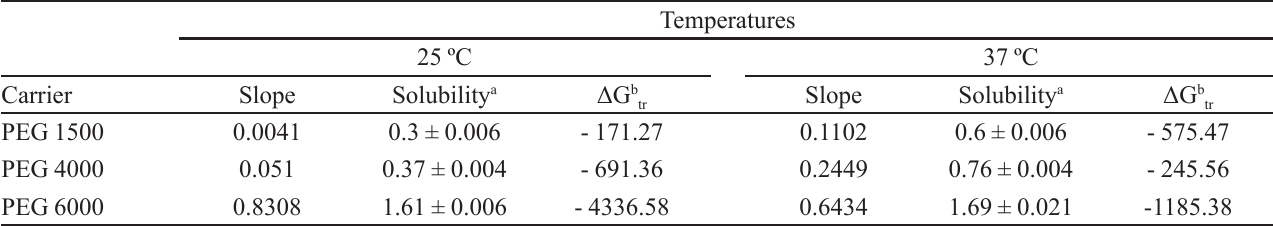
TABLE II - Parameters for phase solubility studies of AMH obtained with different carriers at 25 and 37 ºC ± 0.5 ºC